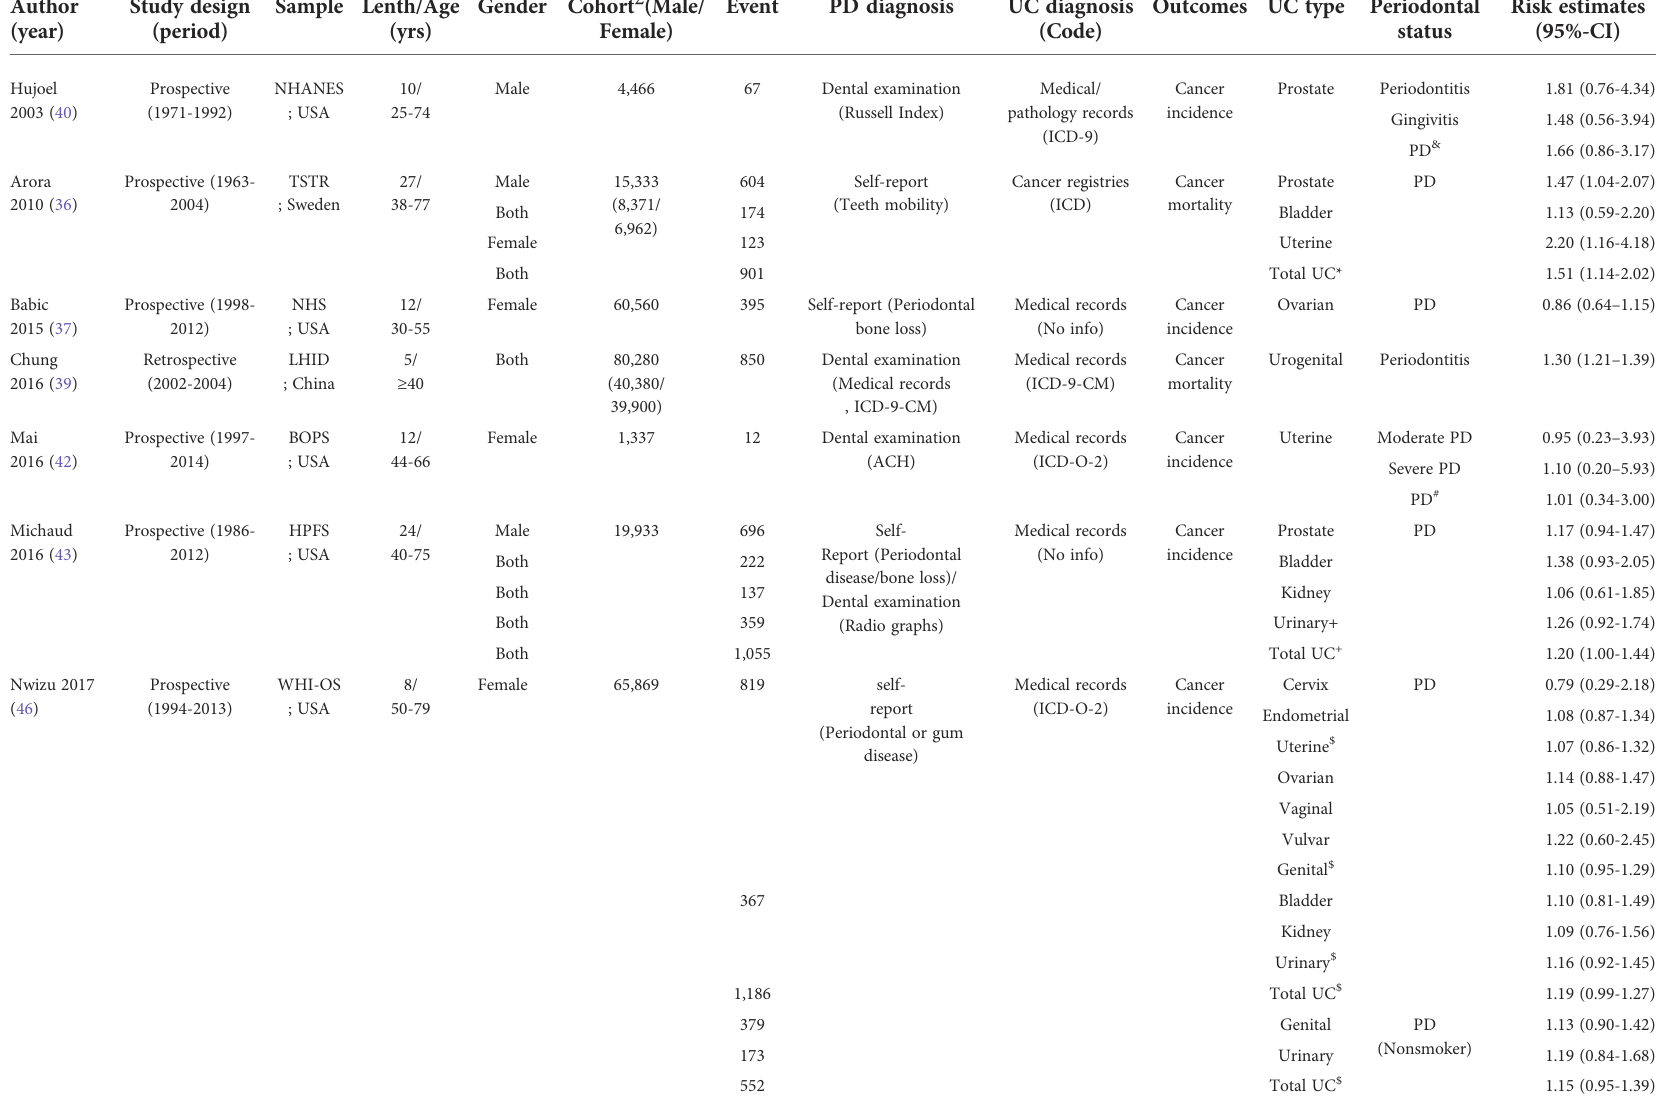
Characteristics and quality assessments of the included